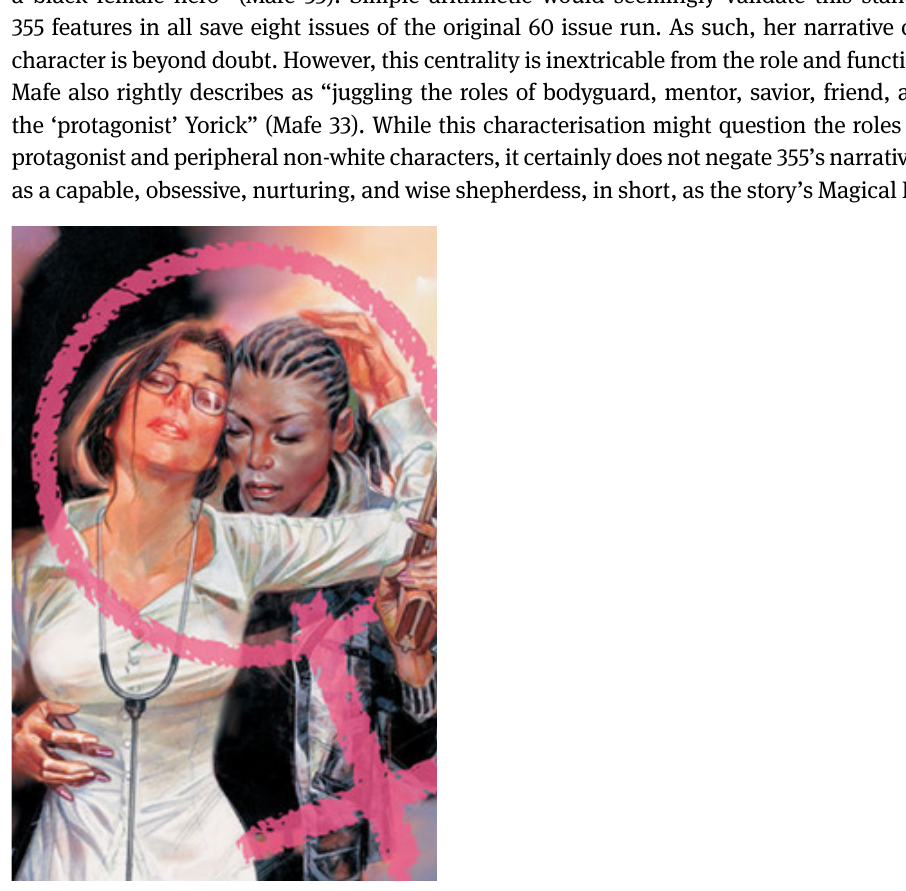
Figure 6. Y: The Last Man: Girl-on-Girl Vol. 6 (2005), cover by Massimo